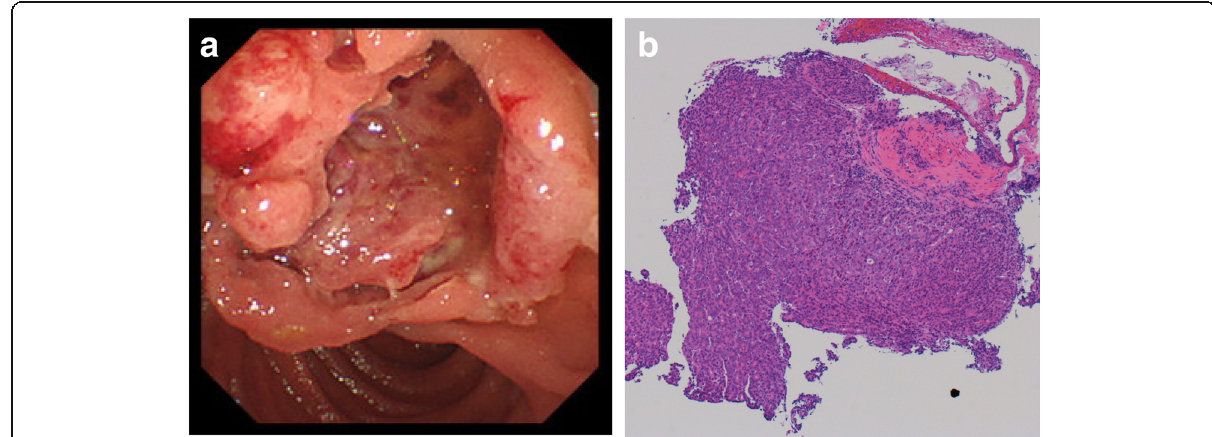
Fig. 1 a Endoscopy revealed an irregularly shaped ulcerated tumor in the ampulla of Vater. b The biopsy specimen suggested moderately to poorly differentiated adenocarcinoma